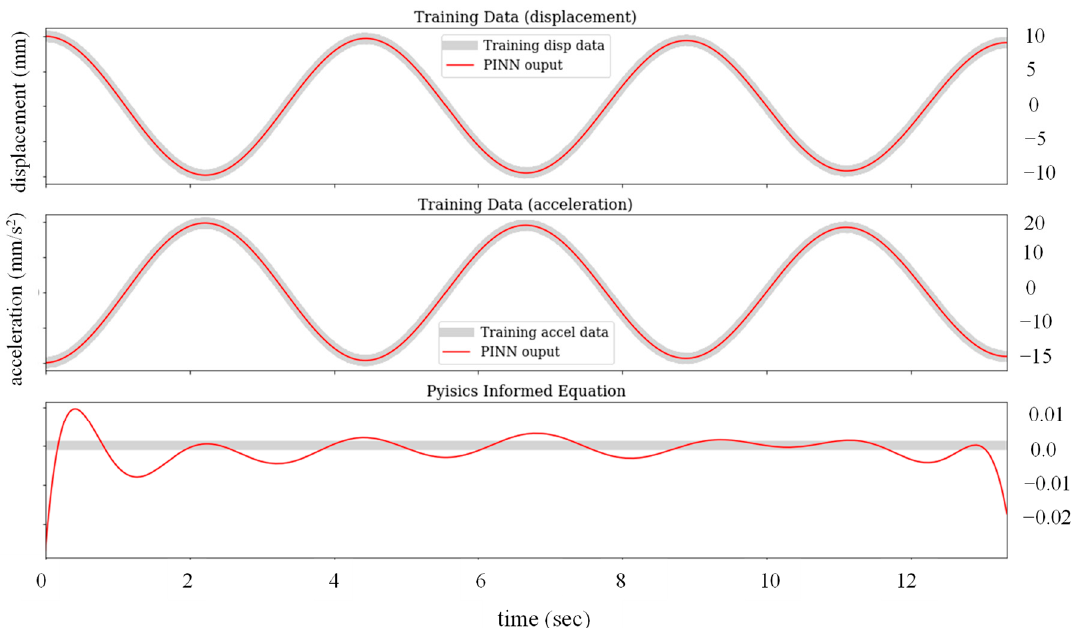
Figure 11. Constraint satisfaction of the PINN during three natural periods of training: ( top ) input data consistency with estimated displacement; ( middle ) estimated acceleration; ( bottom ) physics equation satisfaction 0*.